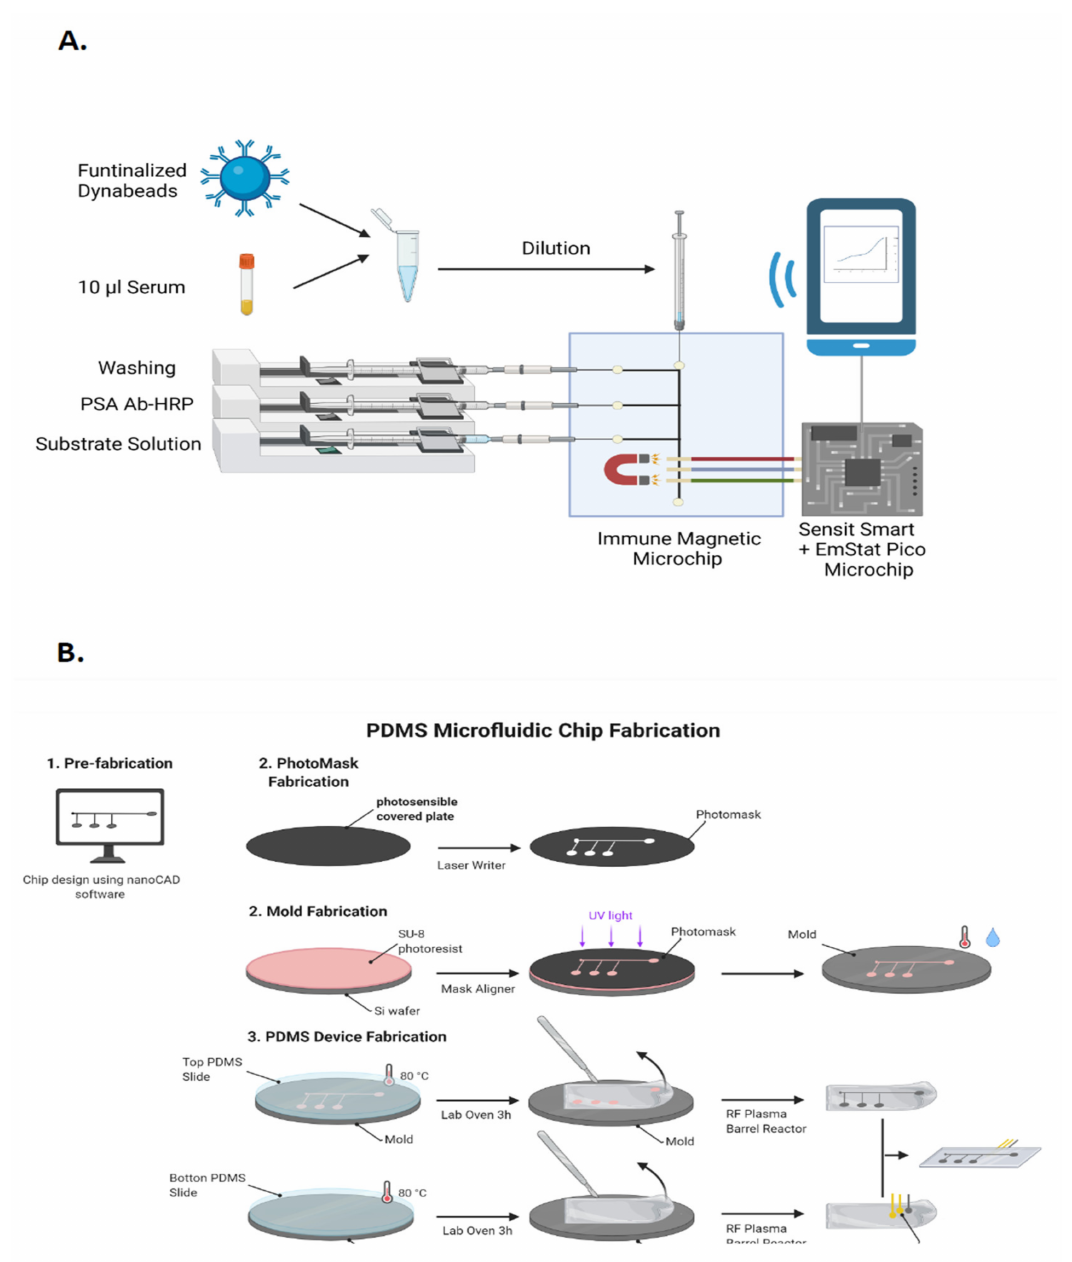
Figure 1. ( A ) Schematic representation of the Smartphone FAST-PSA tool . ( B ) Schematic representation of the microfluidic chip